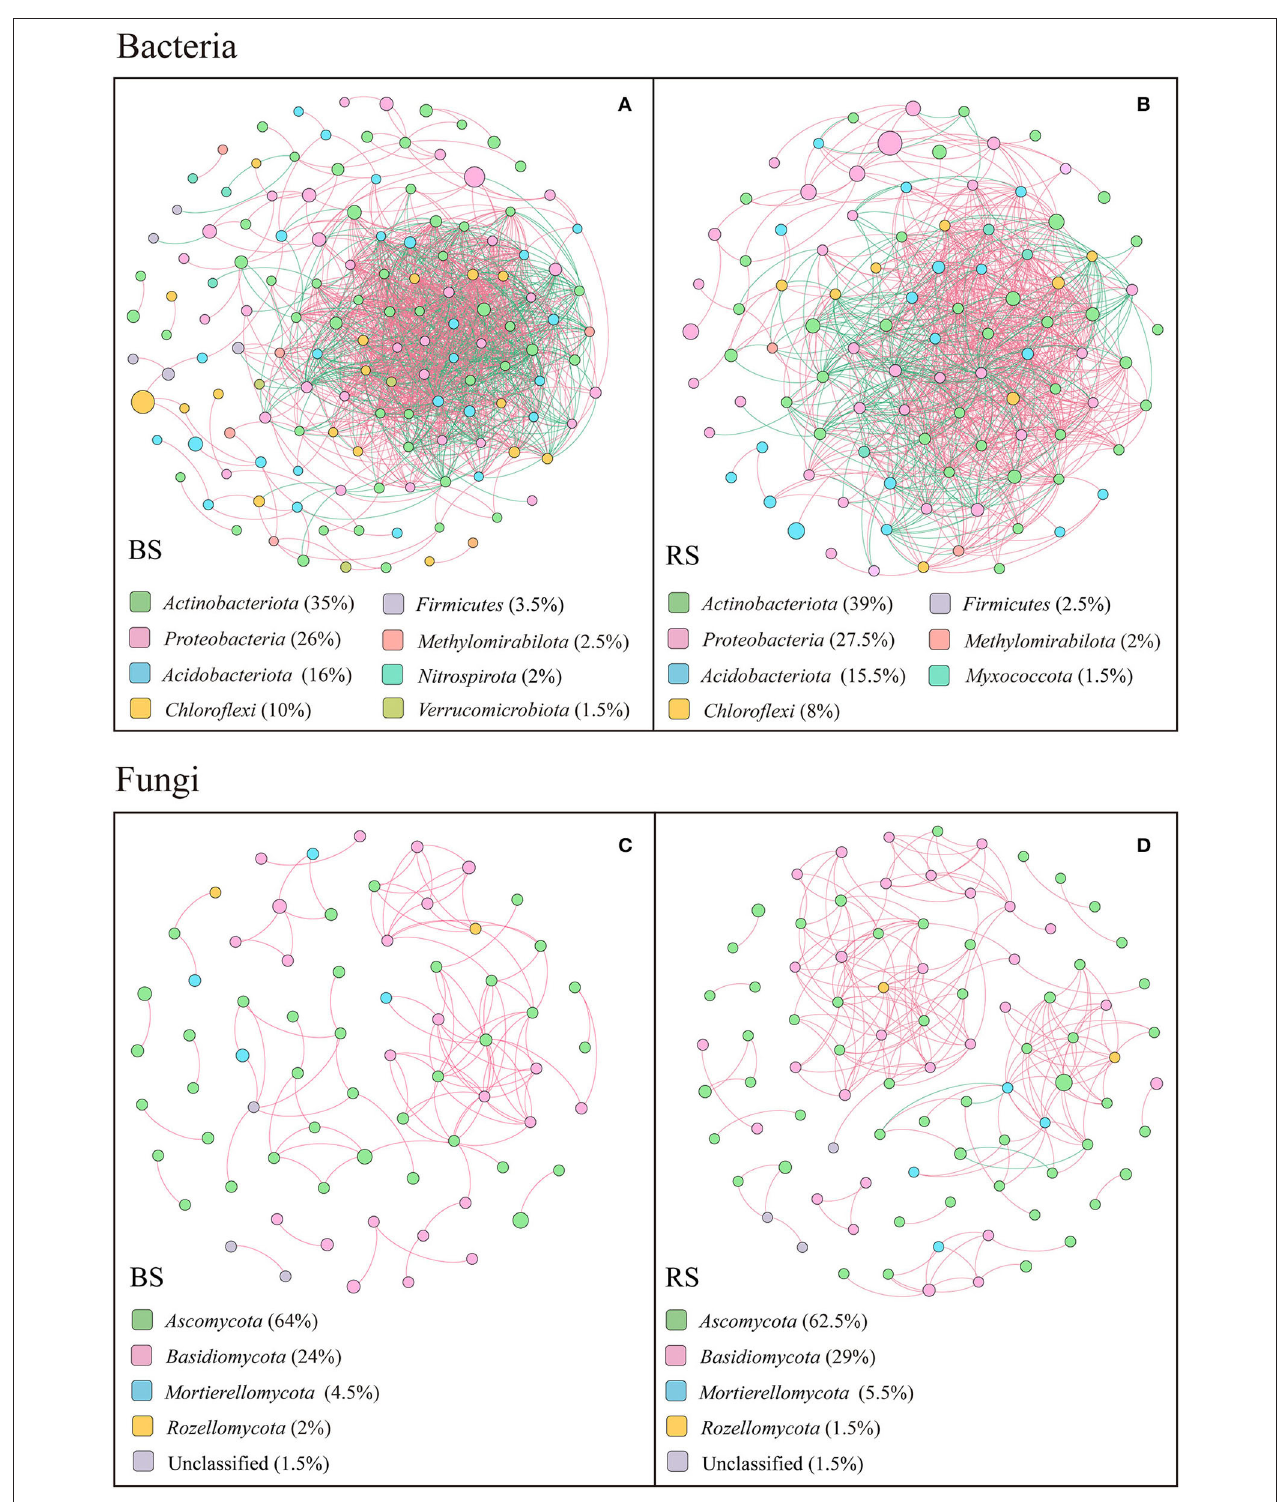
FIGURE 7 | Results of correlation network analysis of bacteria (A,B) and fungi (C,D) in the bulk soil and the rhizosphere soil. The top 200 OTUs were selected, and Spearman’s correlation coefficient rank between the relative abundances of OTUs was calculated to reflect the correlations. Only OTUs with strong significant correlations are shown in the figure ( p < 0.05 and Spearman’s correlation coefficients size > 0.8). The size of nodes indicates the size of OTU abundance, and different colors indicate different phyla. Red connecting lines indicate a positive correlation, and blue lines indicate a negative correlation. The thicker the line, the higher the correlation between OTUs, and the more the number of lines, the closer the association between the taxa.